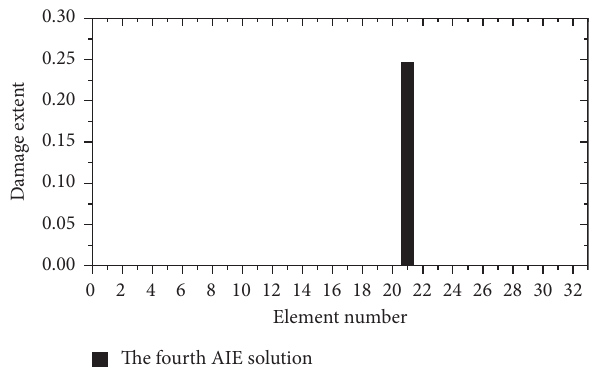
Figure 15: Damage assessment result by the fourth AIE when element 21 is damaged.